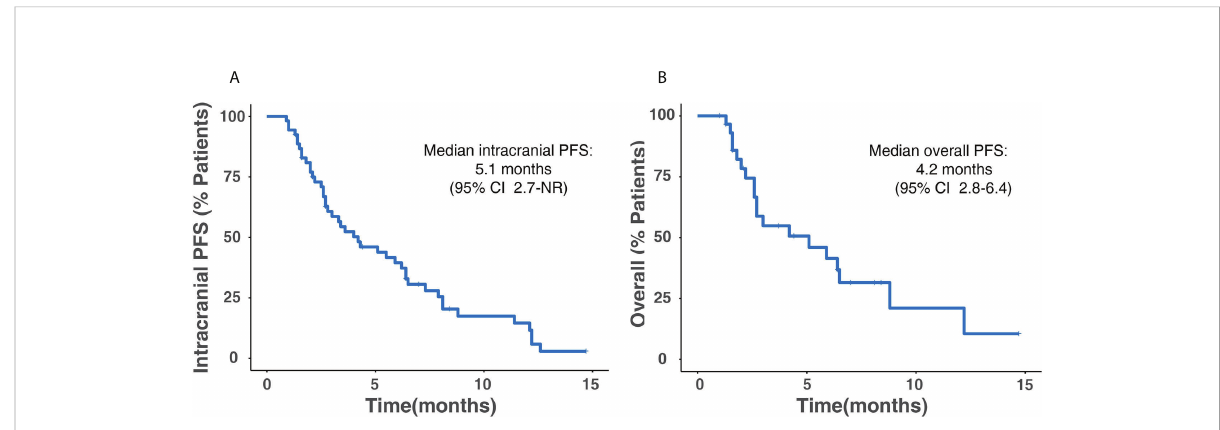
FIGURE 3 Kaplan – Meier survival analysis for all patients. (A) Intracranial PFS. (B) Overall PFS. PFS, progression-free survival; CI, con fi dence interval; NR, not